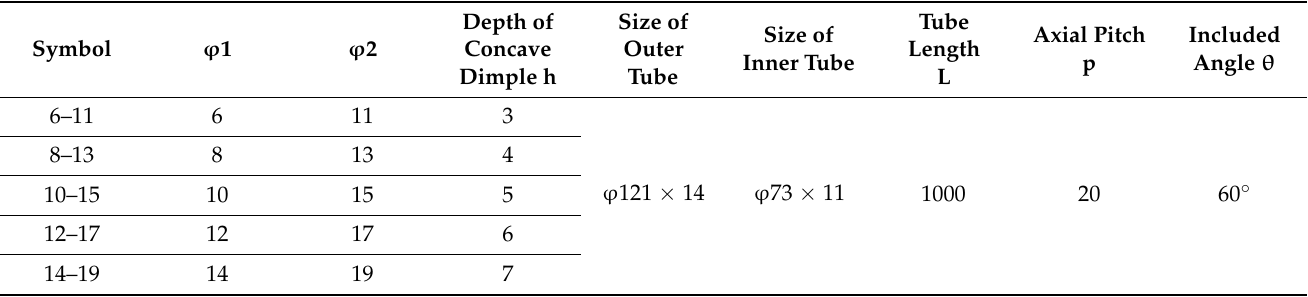
Table 1. Structure and size of dimpled tube.